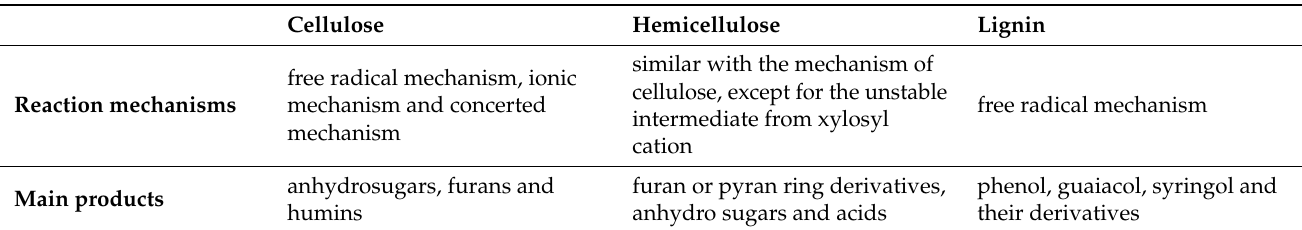
similar with the mechanism of cellulose, except for the unstable intermediate from xylosyl